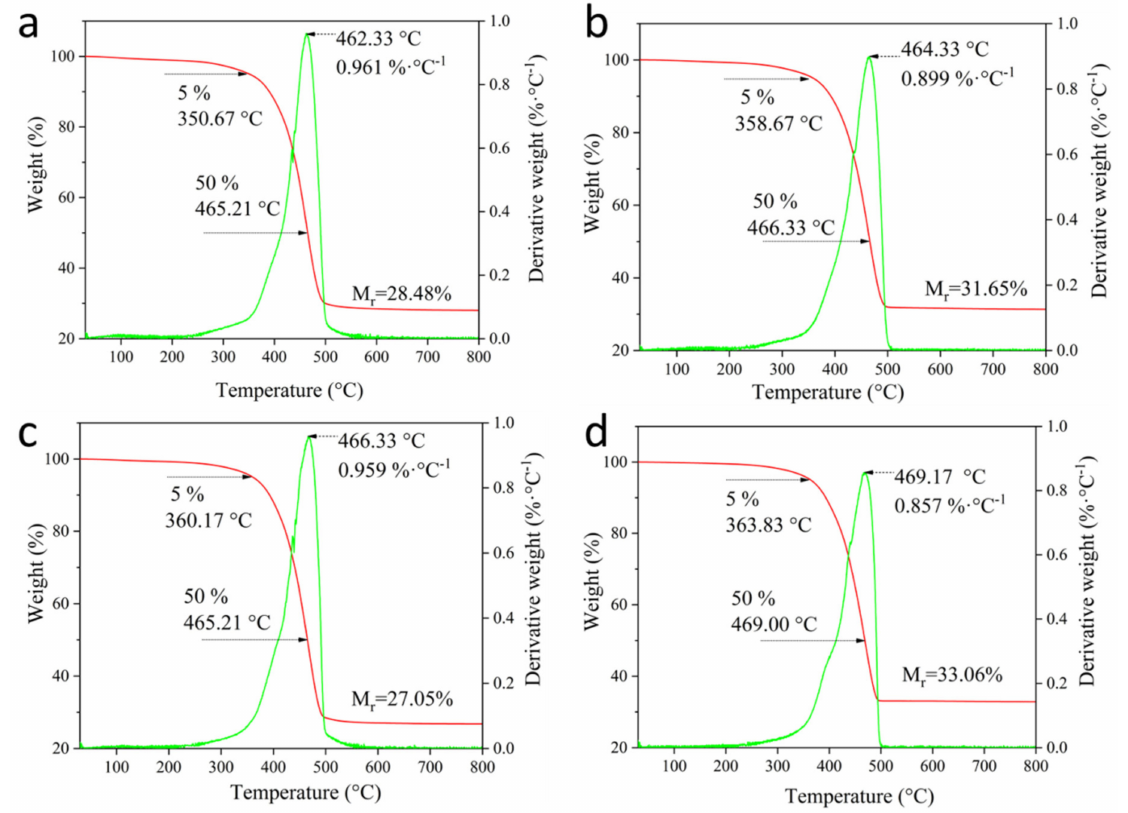
Figure 9. TG-DTG curves of coal gangue reinforced SBR: ( a ) GR-SBR; ( b ) GA-SBR; ( c ) MGR-SBR; ( d ) MGA-SBR. The T 5 , T 50 , T p of GA-SBR, MGR-SBR, and MGA-SBR were larger than those of